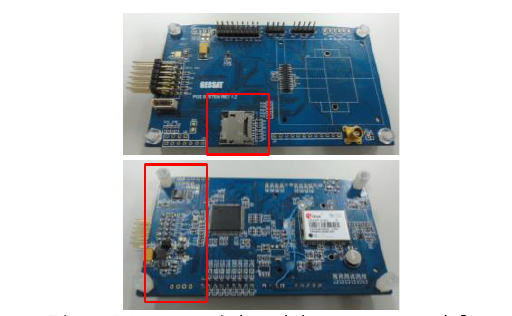
Figure 5 Power switch and data storage module